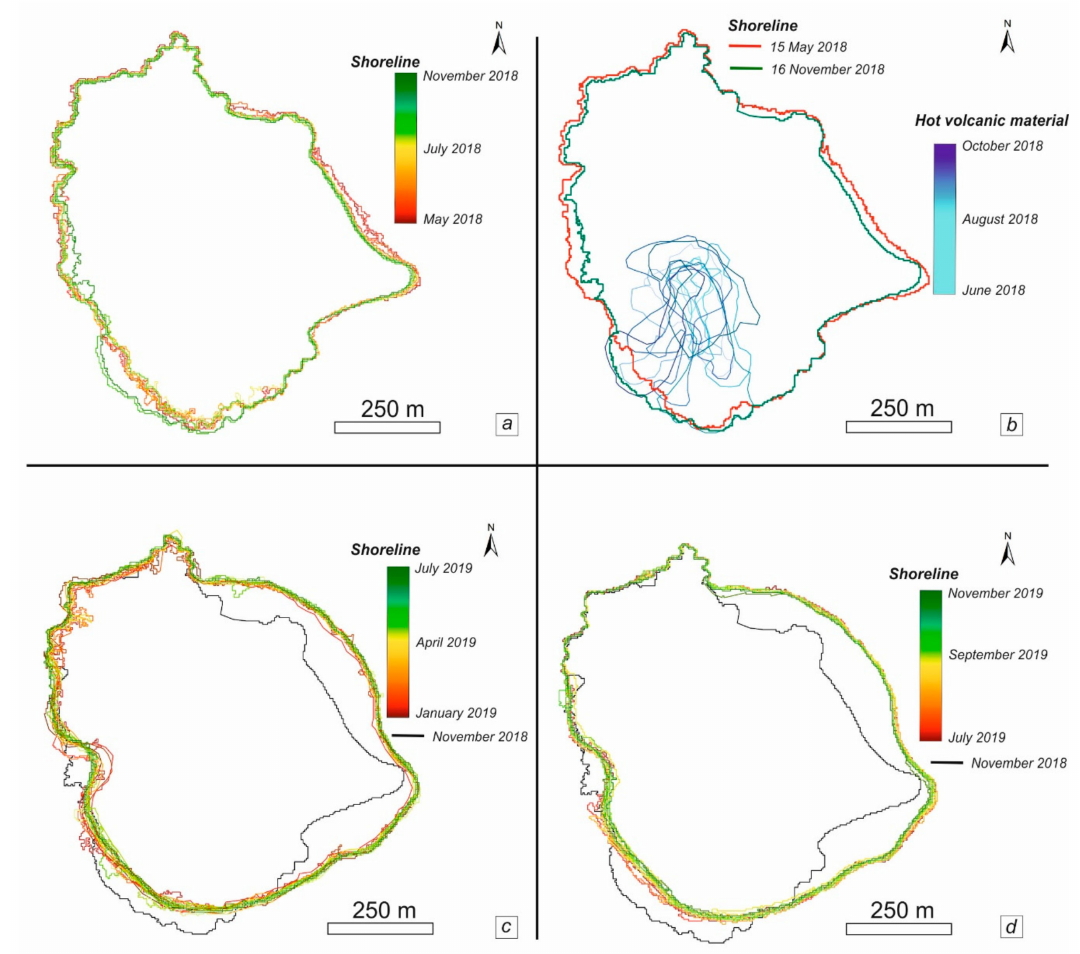
Figure 6. Shorelines map for the AK Island. Shorelines for the May 2018 and November 2018 period ( a ). Shorelines on 15 May 2018 and 16 November 2018 with extent of the hot volcanic material detected from thermal anomalies ( b ). Shorelines for the November 2018 and July 2019 period ( c ). Shorelines for the July 2019 and November 2019 period ( d ). The 16th of November 2018 shorelines, the last before the collapse, are shown as black polyline in ( c , d